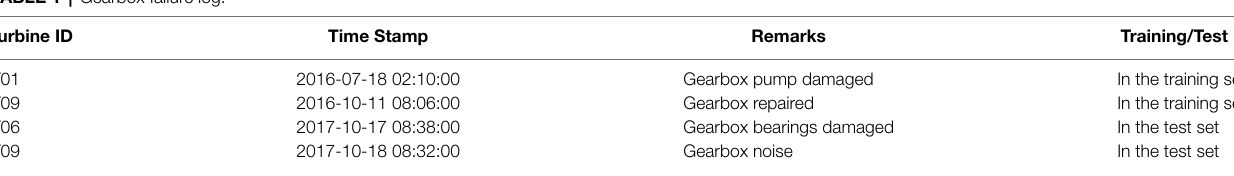
TABLE 1 | Gearbox failure